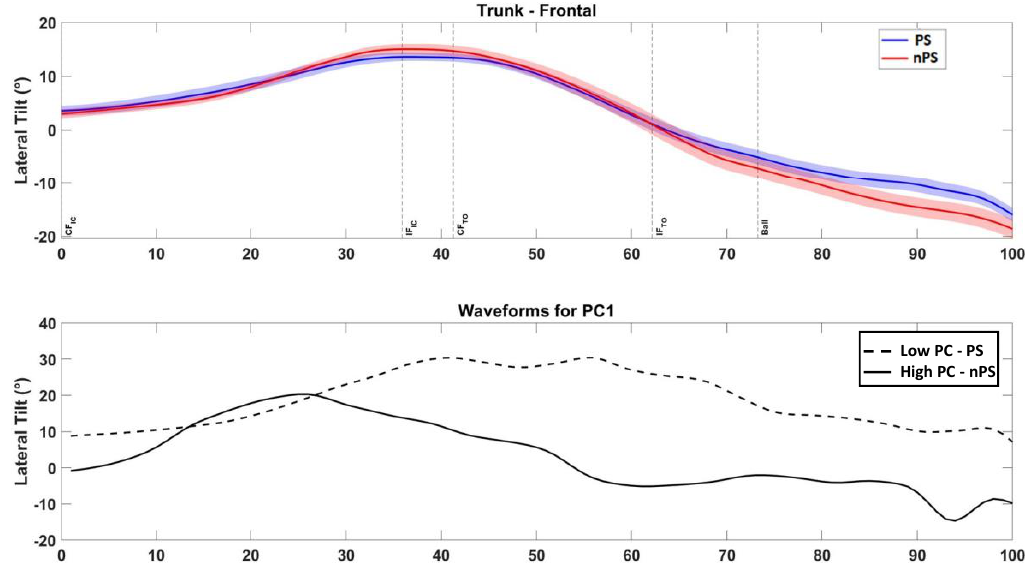
Figure A2. HIGH DIVE—Pelvis/Trunk/Head: in the bottom row, preferred side waveform is represented by the low PC (dashed line) for this kinematic variable. Note: PS = preferred diving side; nPS = non-preferred diving side; PC = principal component; IC = initial contact; TO = toe-off, CF = contralateral foot; IF = ipsilateral foot; Ball = ball